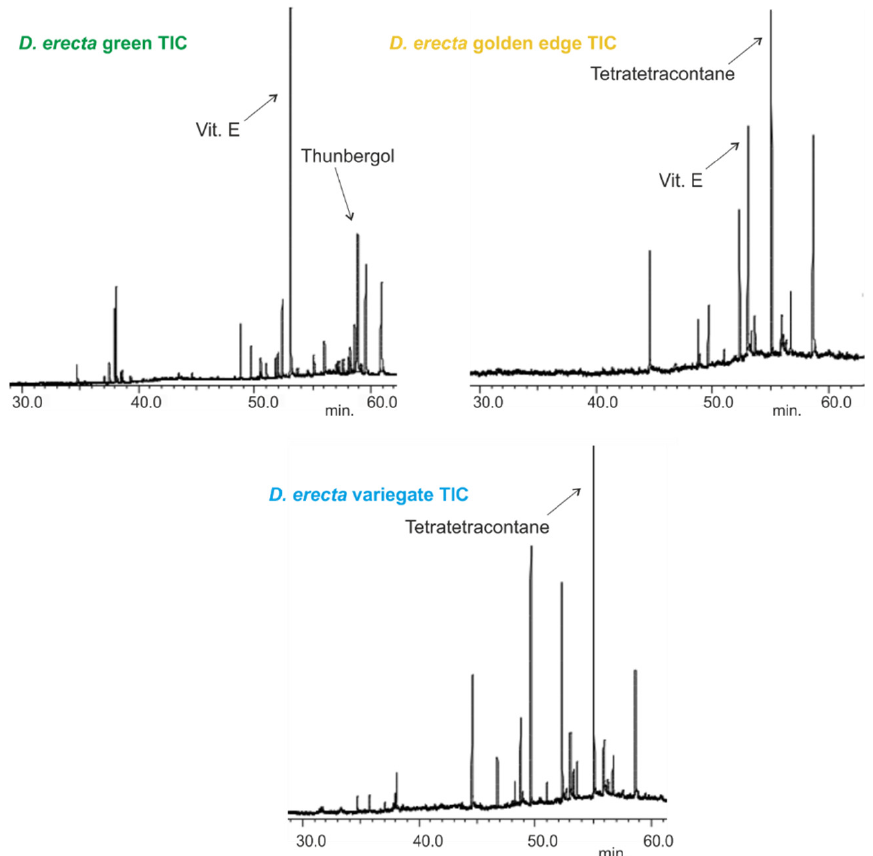
Figure 1. Total ion chromatograms (TIC) of the leaf oils extracted by n -hexane of three Egyptian Duranta erecta cultivars.